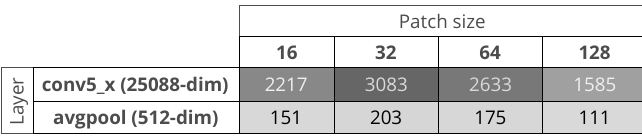
Figure 6. Dimension of the feature vectors after Principal Component Analysis